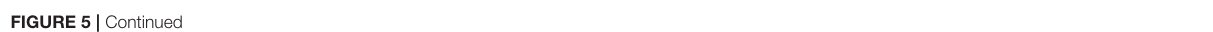
To further confirm the role of G α in roots’ eATP avoidance response, seedlings of WS and G α null mutants were transplanted onto diagonally-jointed medium which containing ATP on right- lower side. When root tip approached the jointed line, roots of WS bent to left, however, roots of gpa1-1 and gpa1-2 grew straightly downward (Figure S4A). In root tip of WS seedlings, after such an asymmetric ATP stimulation, fluorescence intensity of DR5-GFP or PIN2-GFP in left-side cells was higher than in right-side cells (Figure S4B). And the ratio of DR5-GFP or PIN2- GFP fluorescence intensity in left-side cells relative to right-side cells was significantly higher than that in untreated seedlings